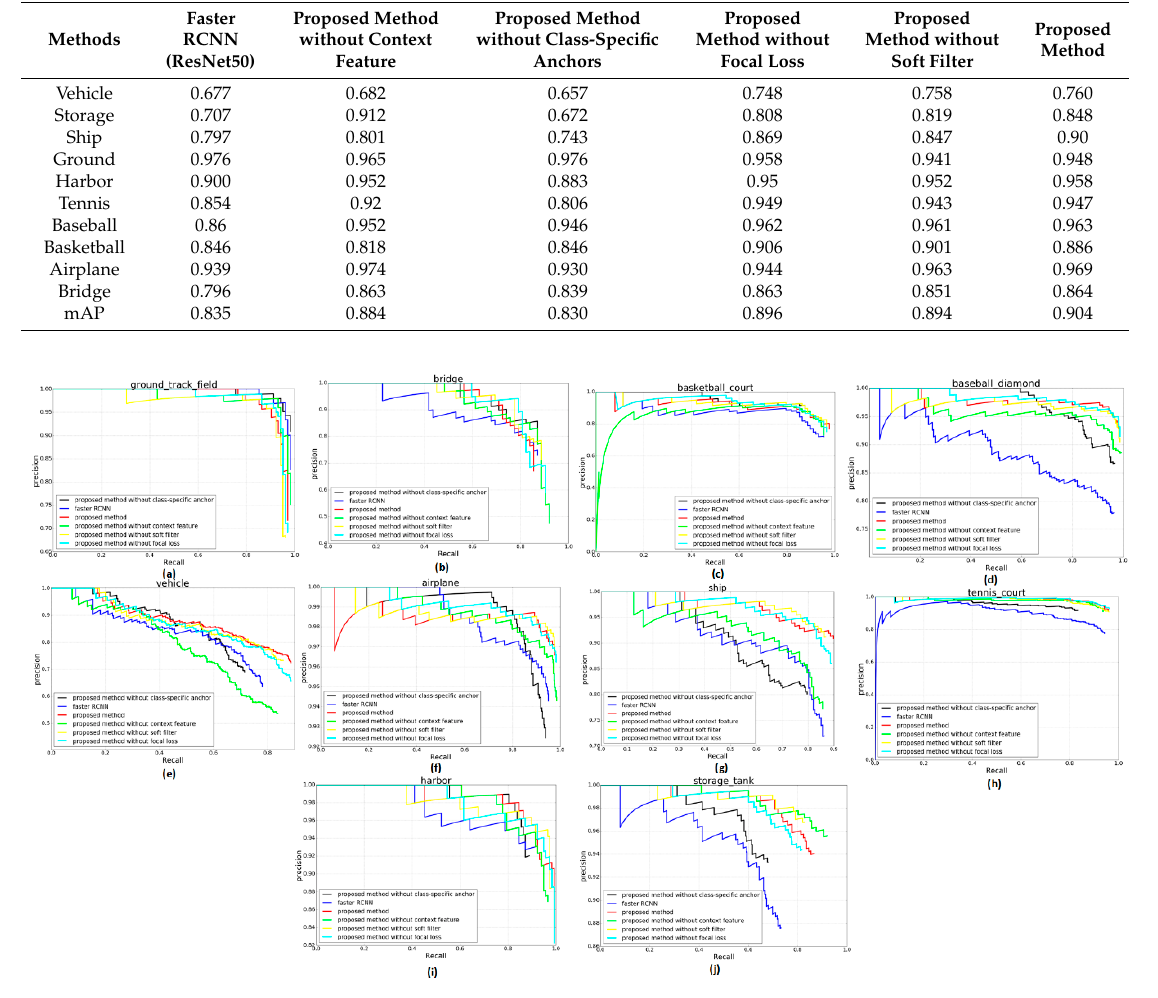
Table 4. Size of Class-specific Anchor for each category.